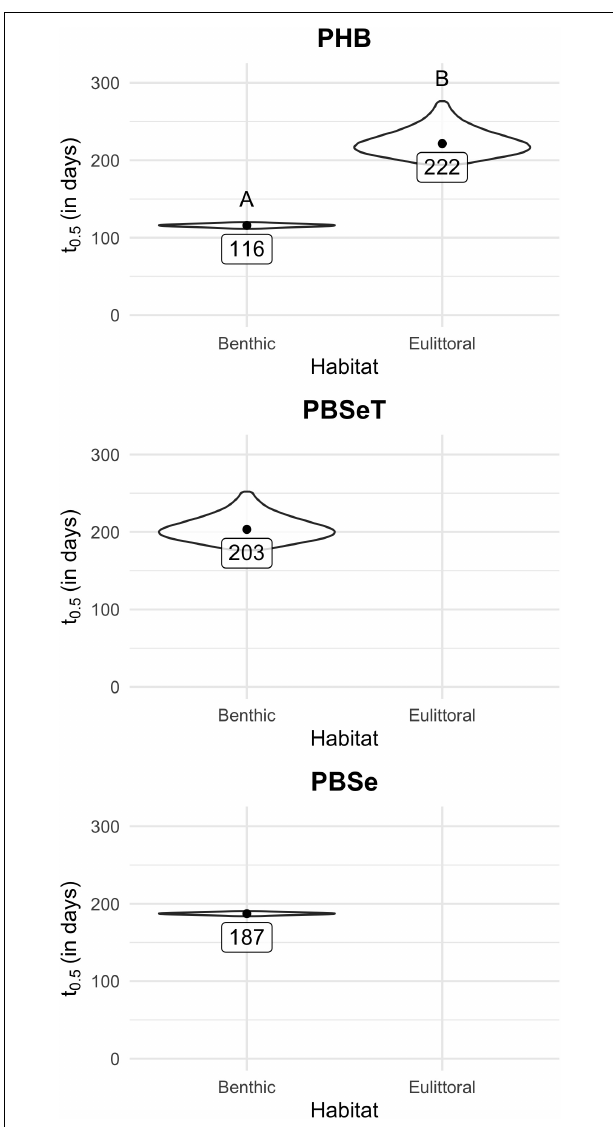
FIGURE 3 | Laboratory experiments with Mediterranean Sea water and sediment: Biodegradation half-lives t 0 . 5 of PHB, PBSe, and PBSeT. Monte Carlo simulations of half-life for tested polymers in two habitats, on the seafloor at the sediment-seawater interface (benthic) and the beach scenario (eulittoral). Shown is the distribution of the centered 95 percentiles of the simulations as violin plots. The dot in the center of each violin represents the half-life as calculated from the estimated model coefficients; the value is given in the box below. Letters above the violin plot represent the results of the multiple comparisons. Different letters (A, B) indicate significantly different groups (i.e., Holm-adjusted p -value below α = 0.05). For PBSeT and PBSe in the eulittoral habitat, no half-life could be calculated because the plateau phase was not reached and values remained below 50 % ( cf. Figure 2 ).